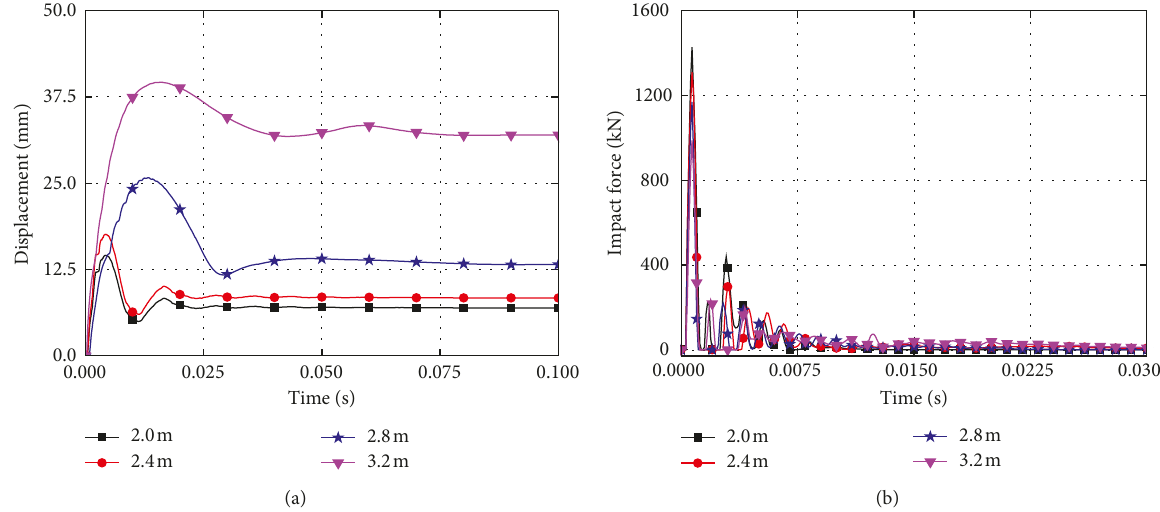
Figure 12: Comparison of impact response of different lengths of beam span. (a) Comparison of midspan displacement. (b) Comparison of impact force.